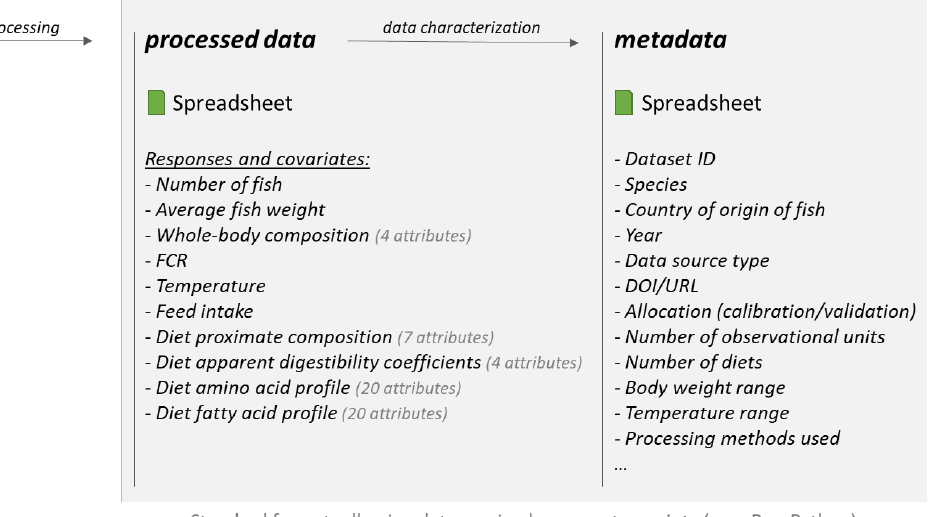
Figure 2. Diagram describing the data set structure, comprising three types of data: raw data , processed data , and metadata .